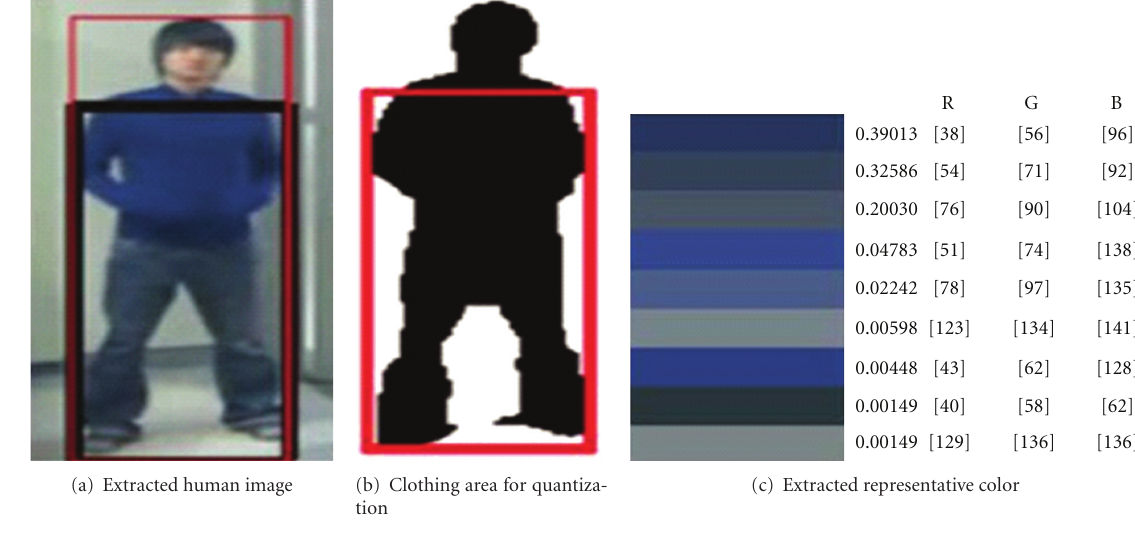
Figure 6: Color quantization result of the clothing region.